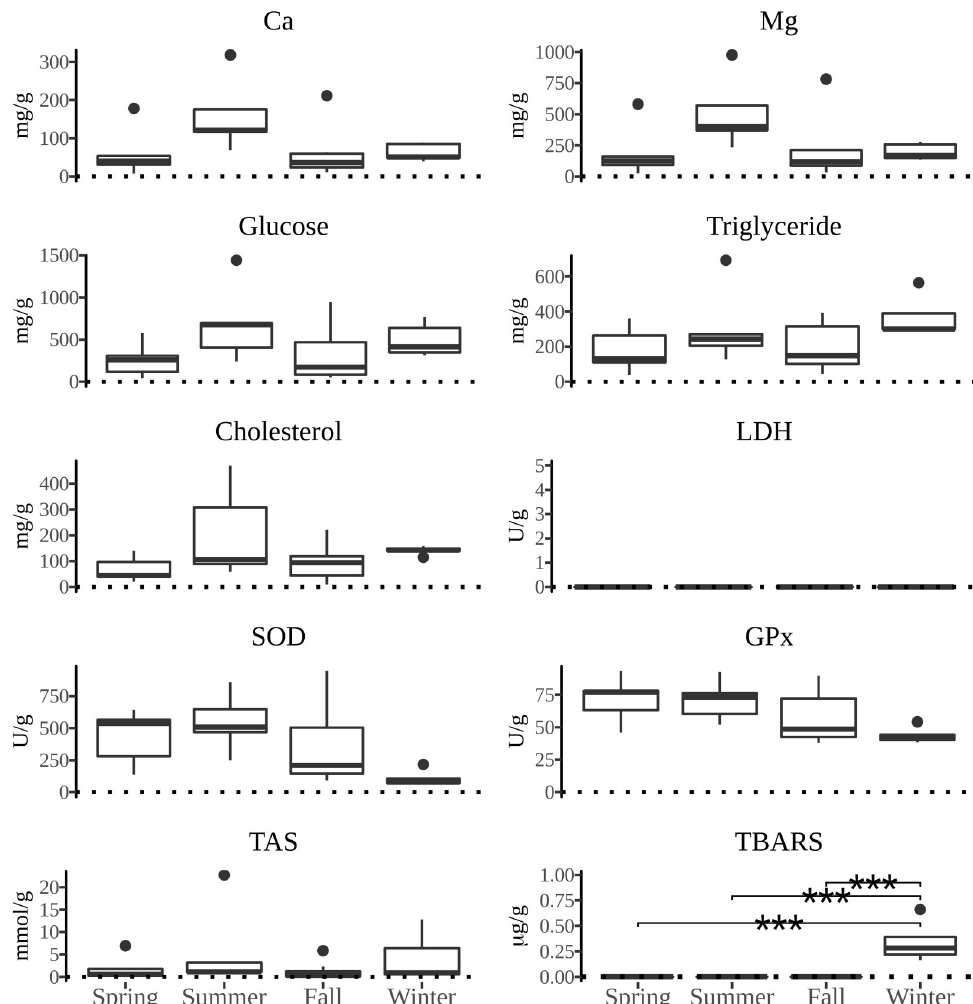
Fig 3. The boxplot distribution of biochemical parameters in gonads of Pecten jacobeus between seasons of the year. The lines above boxplots show the significance level ( � p < 0.05, �� p < 0.01, ��� p < 0.001) of differences between seasons in the pairwise comparison. The endpoints of the lines mark two seasons with significant